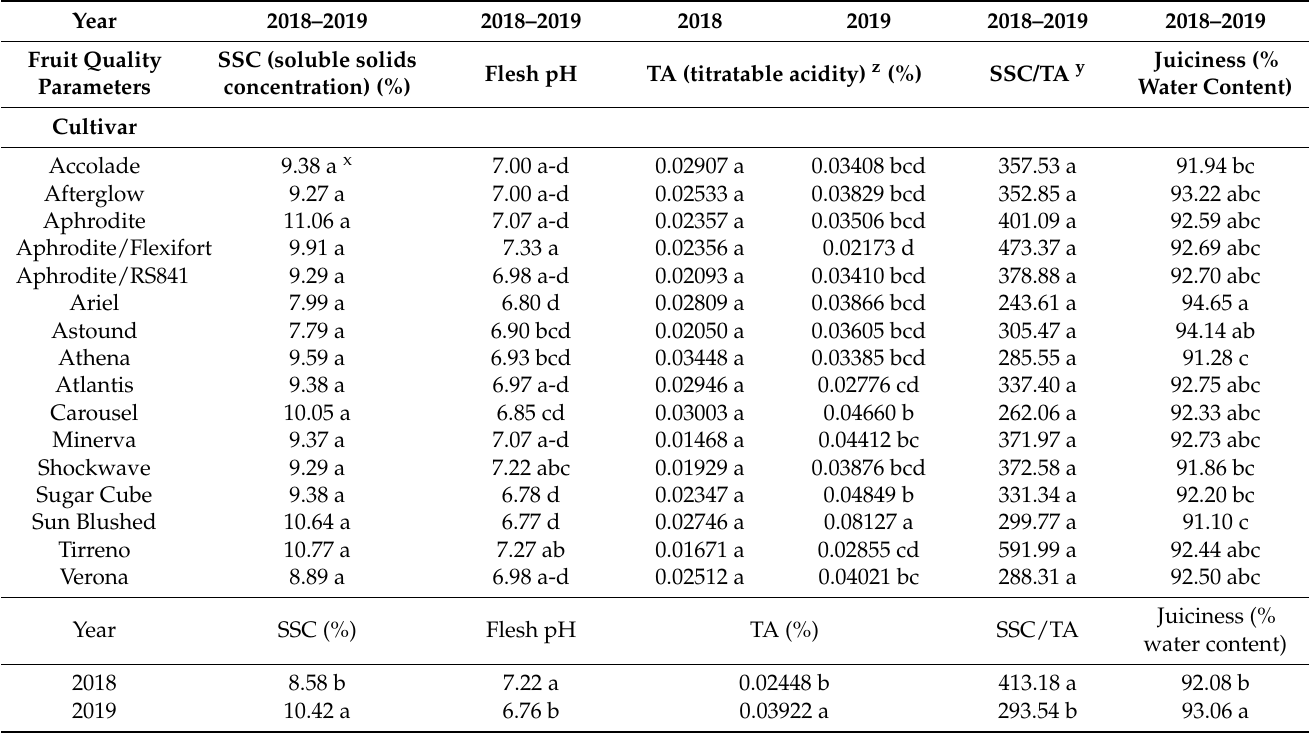
Table 9. Physiochemical quality properties of 14 muskmelon cultivars and two grafted entries evaluated in central Pennsylvania in 2018 and 2019.